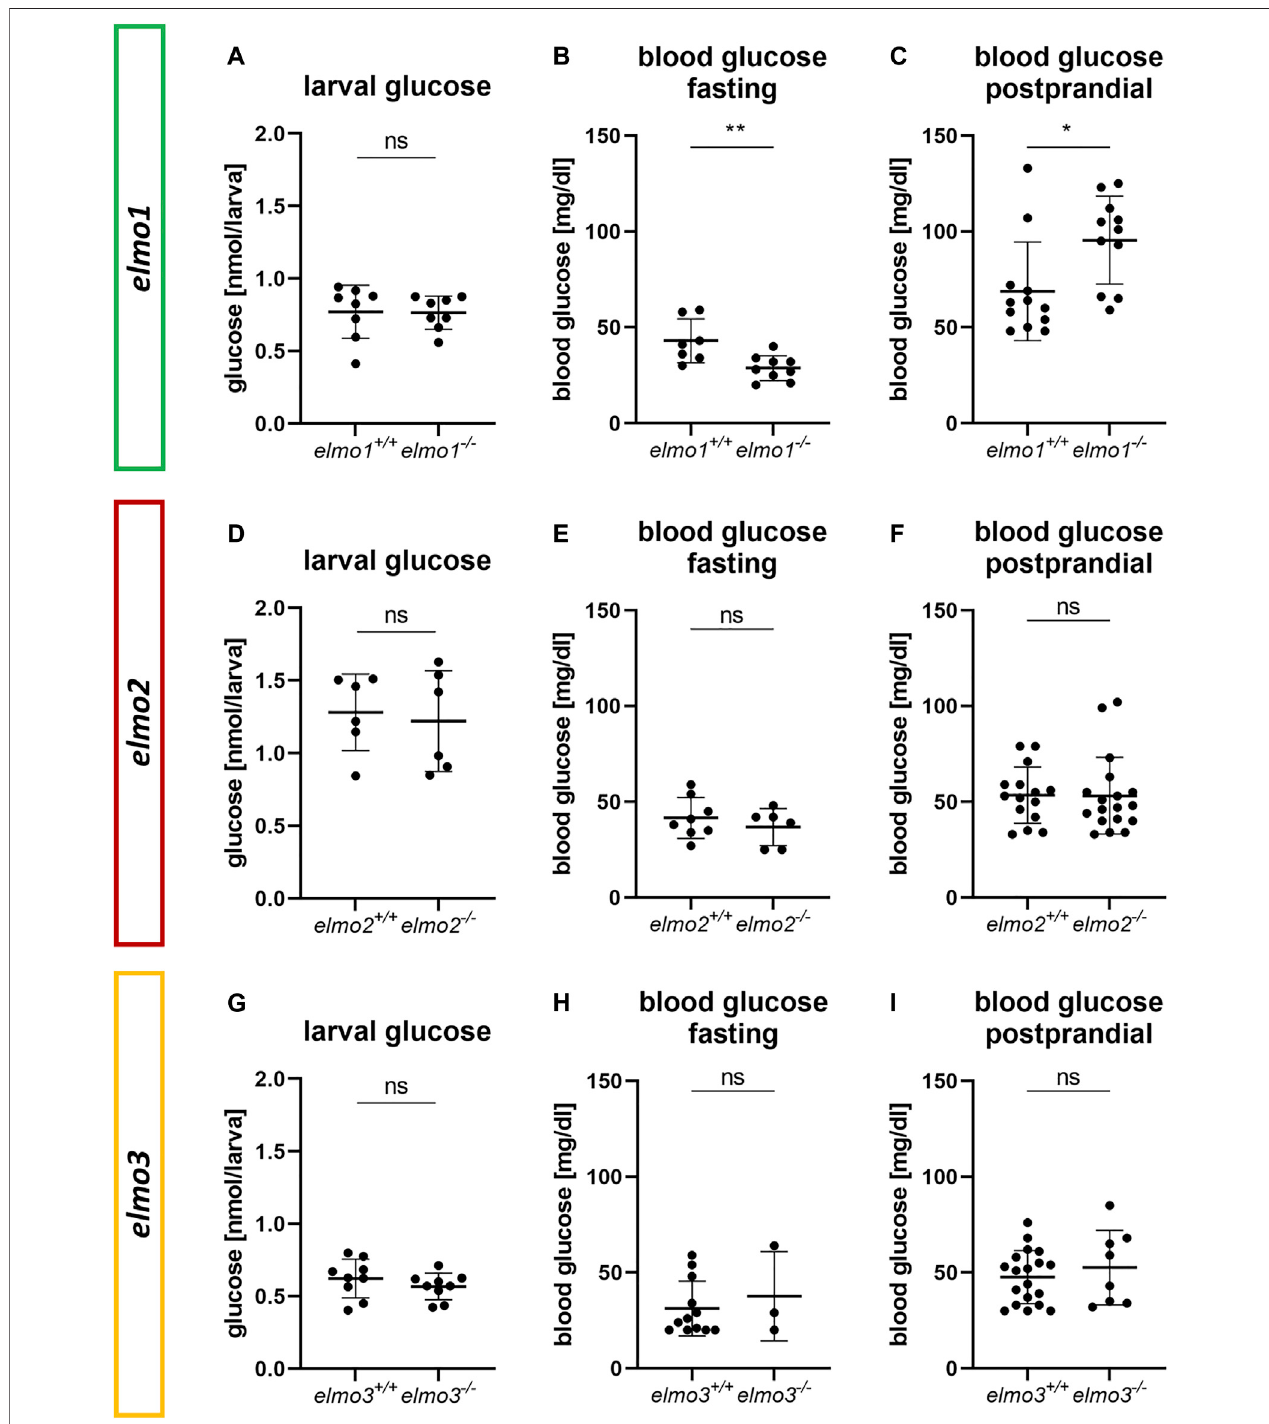
FIGURE 6 | The loss of Elmo1 led to altered blood glucose levels in adult zebra fi sh. (A) Whole body glucose levels were not changed in elmo1 − / − compared to elmo1 +/+ at 120 hpf. n = 8 samples per group, each containing 20 zebra fi sh larvae. (B) Fasting blood glucose levels were decreased in adult elmo1 − / − . (C) Postprandial bloodglucoselevelswereincreasedinadult elmo1 − / − . (D) Wholebodyglucoselevelswerenotchangedin elmo2 − / − comparedto elmo2 +/+ at120 hpf. n =6samplesper group, each containing 20 zebra fi sh larvae. (E,F) Fasting and postprandial blood glucose levels were unaltered in adult elmo2 − / − . (G) Whole body glucose levels were not changed in elmo3 − / − compared to elmo3 +/+ at 120 hpf. n = 9 samples per group, each containing 20 zebra fi sh larvae. (H,I) Fasting and postprandial blood glucoselevels wereunaltered inadult elmo3 − / − .Bloodglucose wasobtainedfrom animalsof7 – 15 mpf.Statisticalanalysiswasdonewith t -testand Mann-Whitney test. * p < 0.05, ** p < 0.01. ns, not signi fi cant; hpf, hours post fertilization; mpf, months post fertilization.